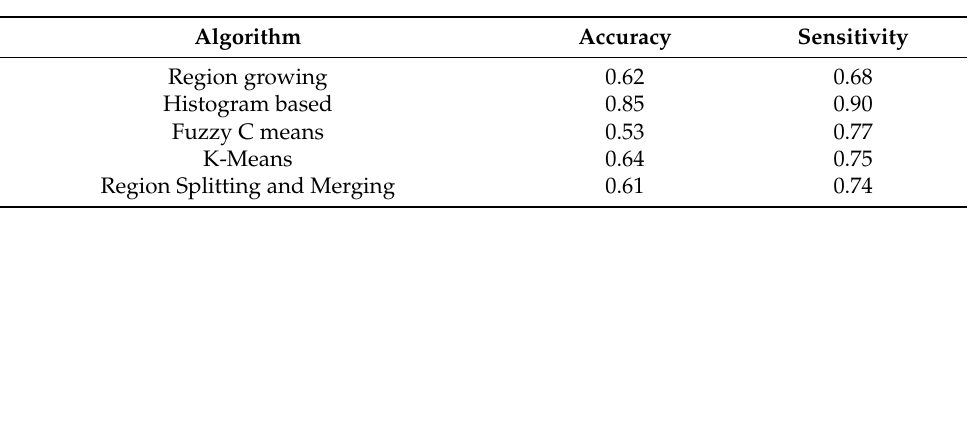
Table 2. Performance analysis of various skull-stripping